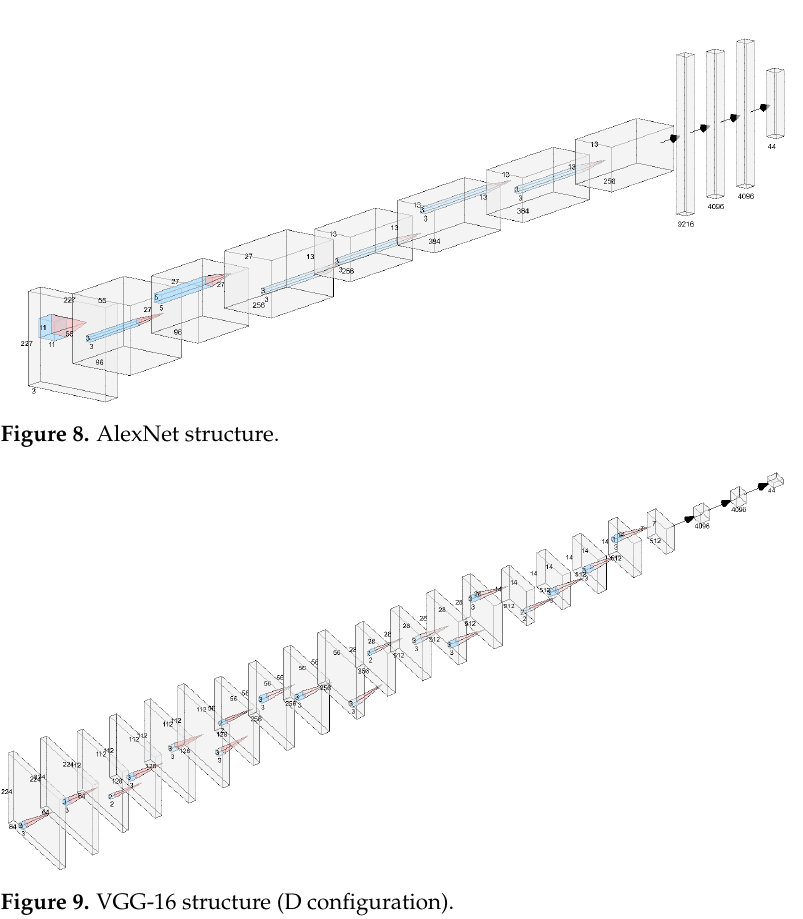
Figure 9. VGG-16 structure (D